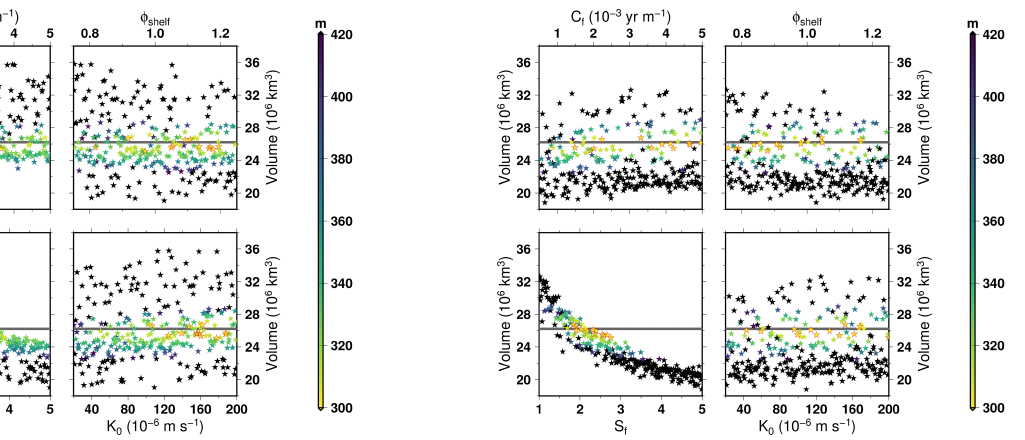
Figure 6. Same as Fig. 5 but with the Tsai et al. (2015) formulation of the flux at the grounding line